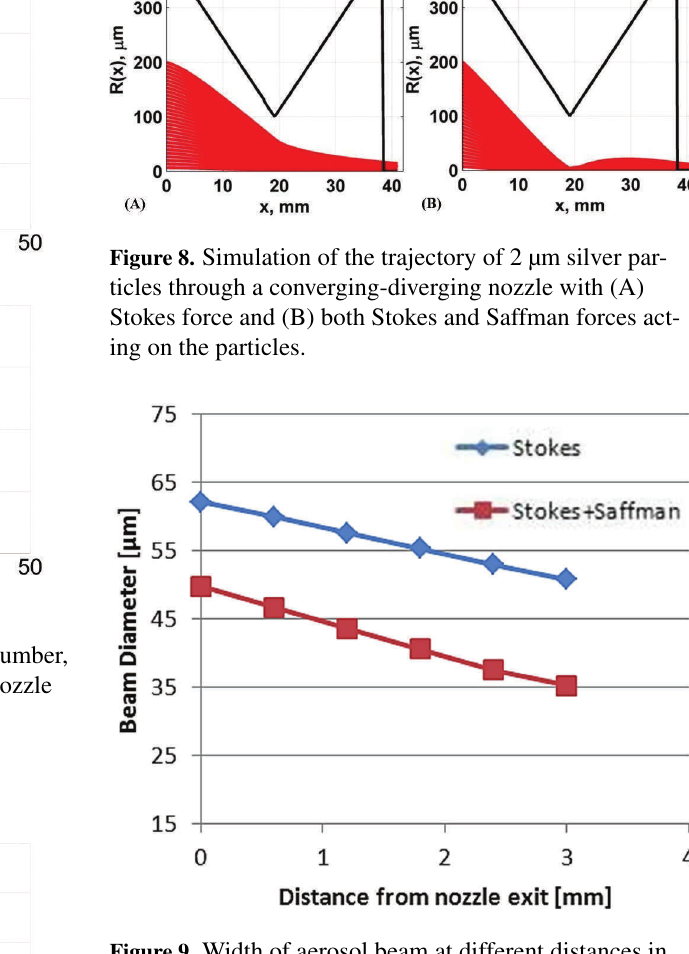
Figure 9. Width of aerosol beam at different distances in the